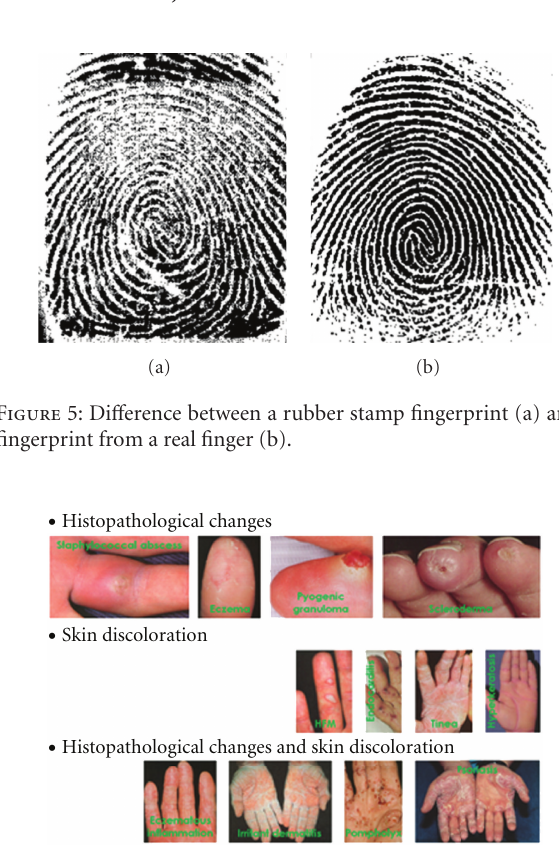
Figure 6: Examples of histopathological changes (upper row), skin discoloration (middle row) and a combination of both previous categories (lower